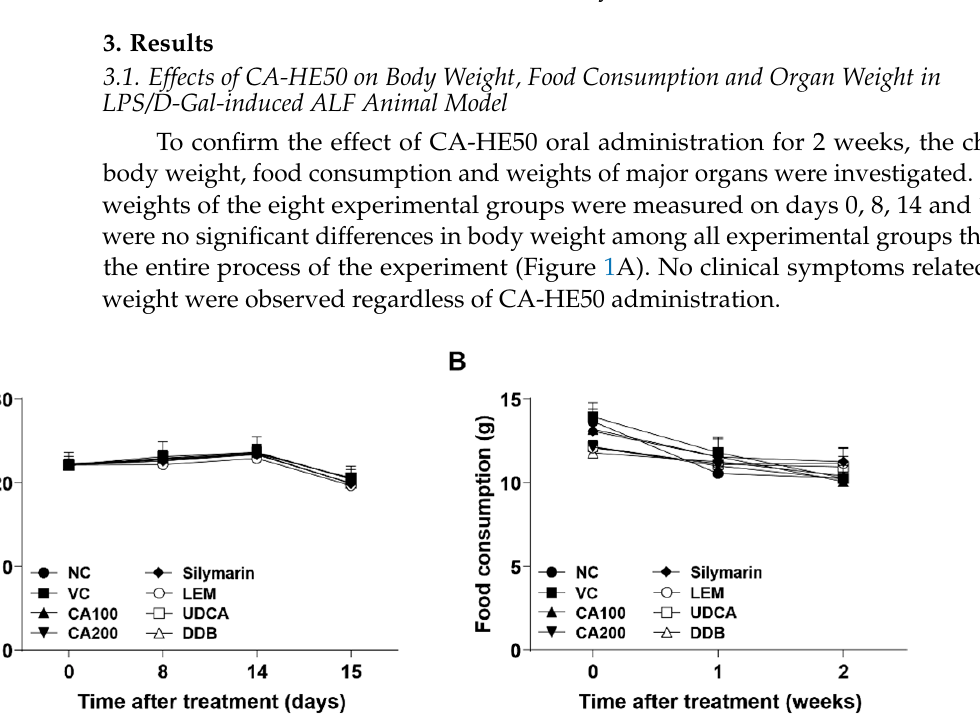
Figure 1. Effects of CA-HE50 on body weight and food consumption changes in LPS/D-Gal-induced ALF animal model. ( A ) The body weights of mice in eight different experimental groups were measured on days 0, 8, 14 and 15. ( B ) Food consumption of each experimental group was measured once per week during the entire experiment. NC, normal control; VC, vehicle control; CA100, 100 mg/kg CA-HE50; CA200, 200 mg/kg CA-HE50; Silymarin, 100 mg/kg silymarin; LEM, 200 mg/kg LEM; UDCA, 25 mg/kg UDCA; DDB, 200 mg/kg DDB. Data are represented as mean ±